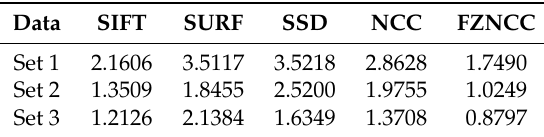
Table 3. Accuracy comparison in terms of